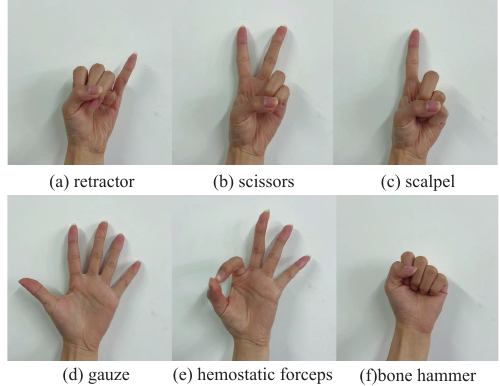
Figure 8. Six kinds of hand